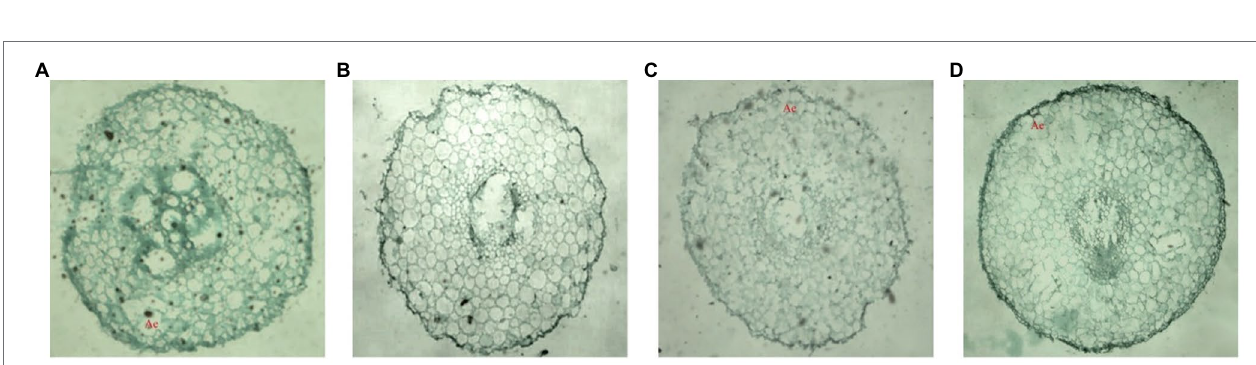
FIGURE 2 | The root tissue micrographs (aerenchyma) of the main roots in two peanut cultivars after waterlogging for 6 days and 9 days. (A) Root microscopic map of ZH4 after 6 days of waterlogging treatment; (B) root tissue microscopic map of XH08 after 6 days of waterlogging treatment; (C) root microscopic map of ZH4 after 9 days of waterlogging treatment; and (D) root microscopic map of XH08 after 9 days pf waterlogging